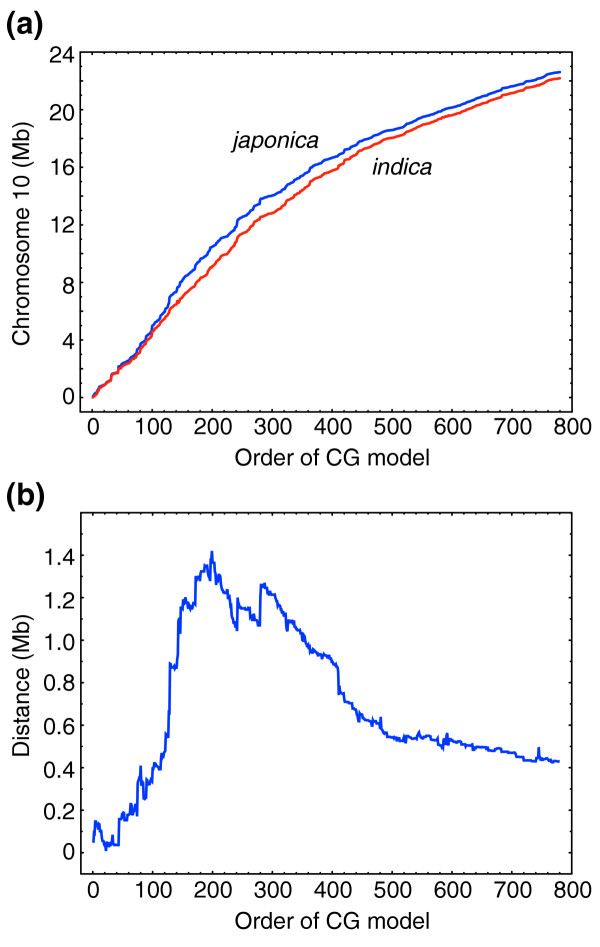
Colinearity of the CG models for chromosome 10 in japonica and indica rice. (a) Chromosomal positions of corresponding CG model pairs along chromosome 10 in japonica (blue) and indica (red) rice are plotted against the sequential orders of the CG pairs. (b) Physical distance between corresponding CG pairs is plotted against their sequential orders along the chromosome.